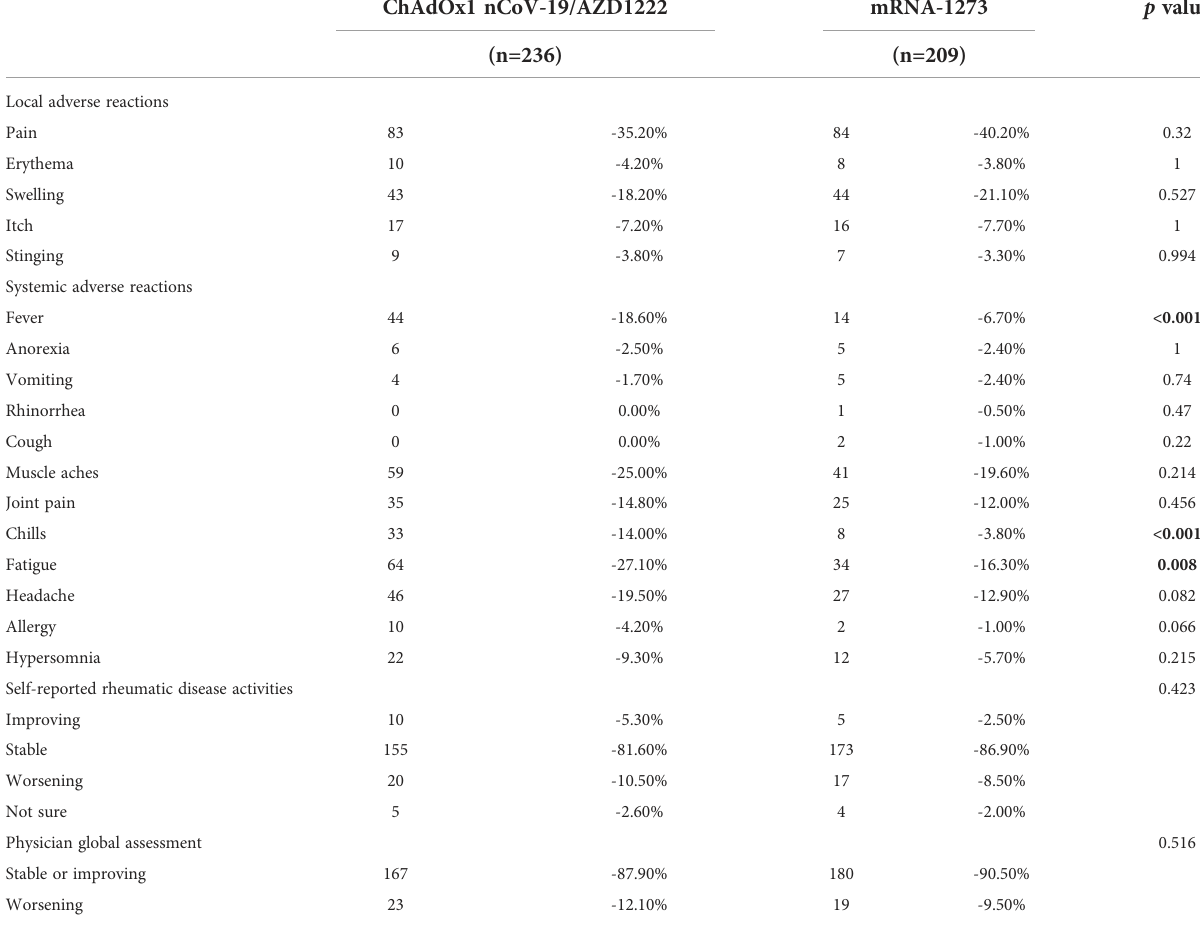
TABLE 3 Adverse reactions and rheumatic disease activities in rheumatic patients after COVID-19